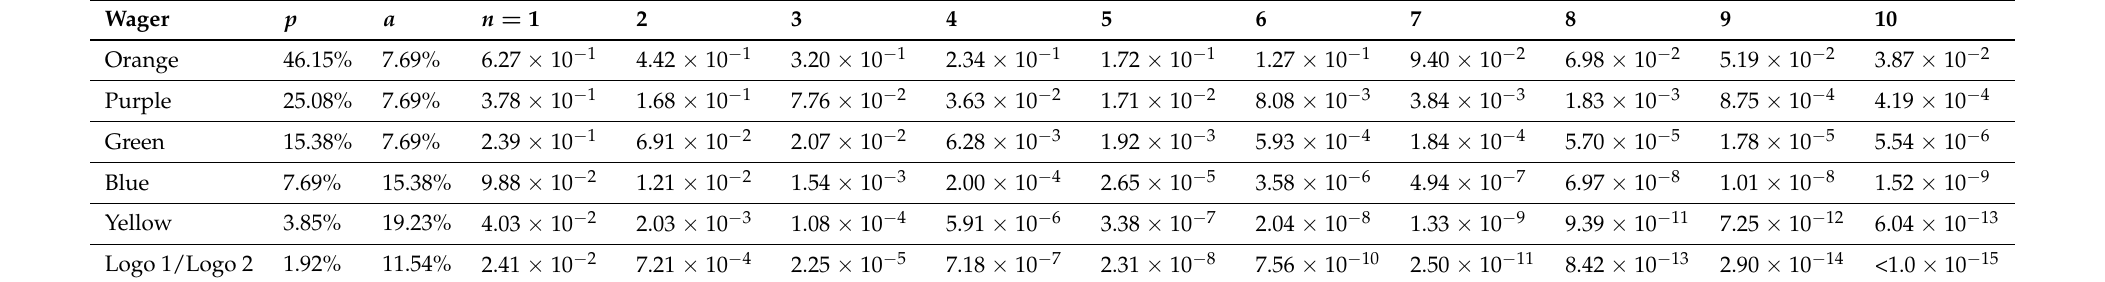
Table 3. The ROR probability obtained by applying the proposed model to each wager of the Big